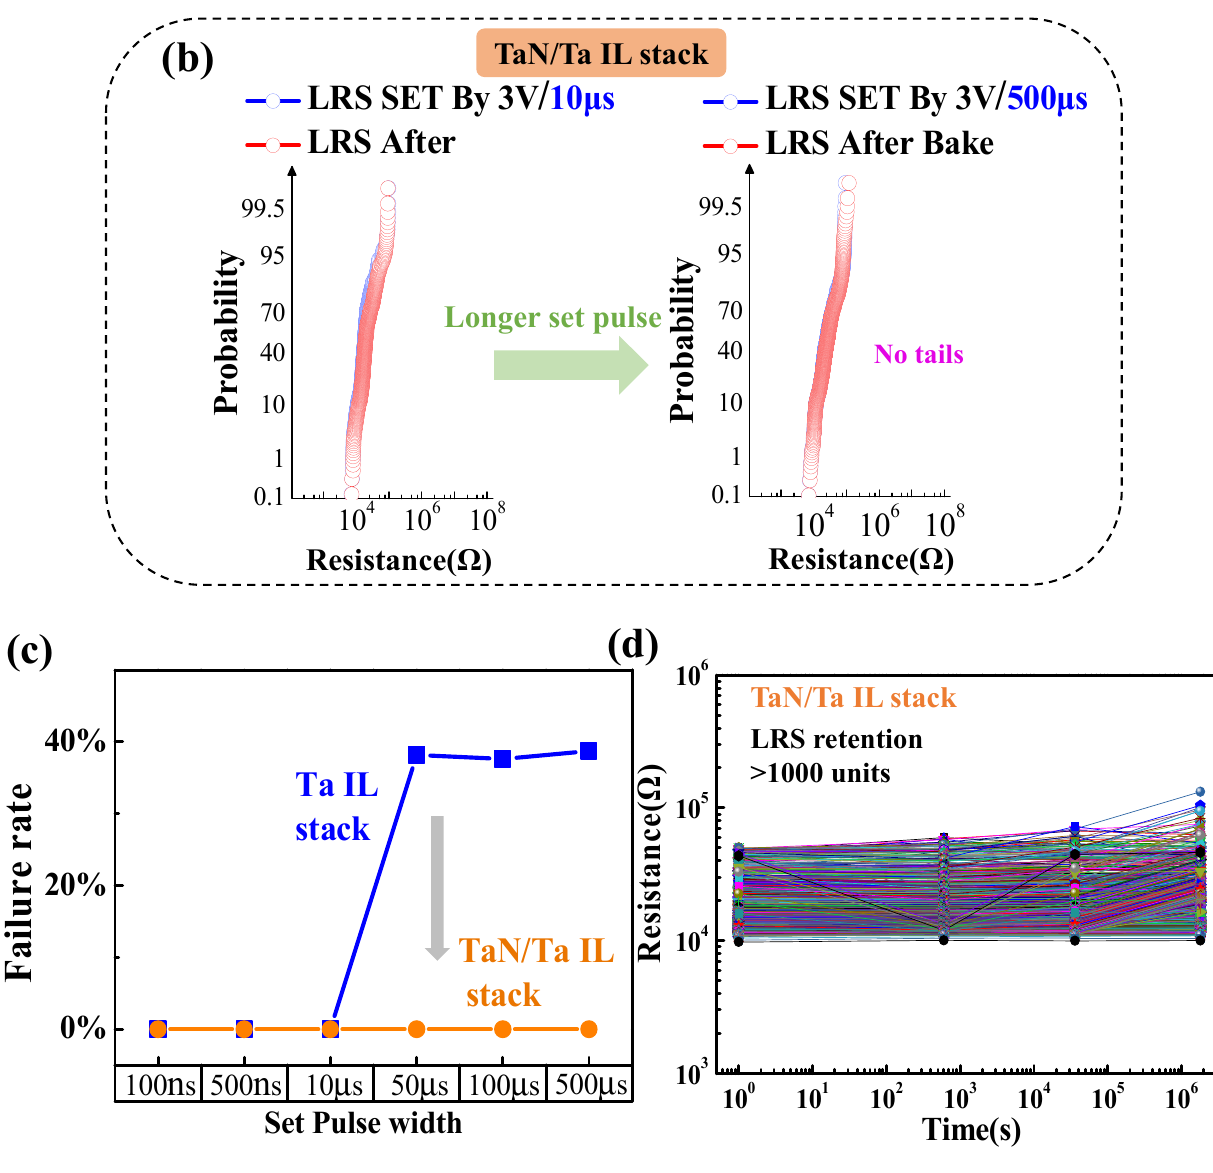
Figure 4. The LRS retention obtained under both a short set pulse and a long set pulse for ( a ) the Ta-IL-stack RRAM and ( b ) the TaN-Ta-IL-stack RRAM. ( c ) The trends of LRS failure rate variations at different set pulse widths. ( d ) LRS retention measurement of the TaN-Ta-IL-stack at 150 °C for 277 h with the forming pulse of 500 μ s.